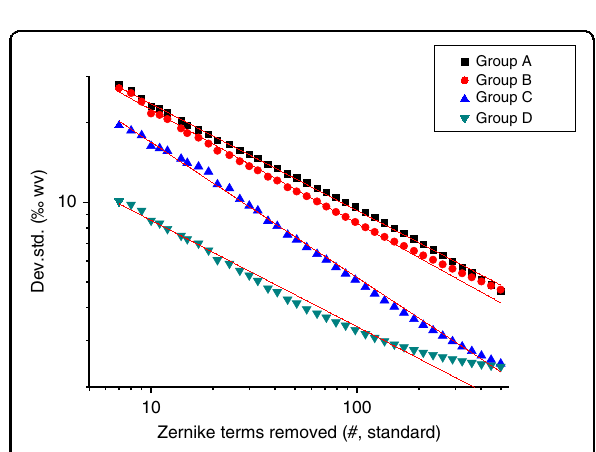
Fig. 20 Logarithmic fi tting curves of Zernike terms for the effect of air turbulence on interferometric tests. The slope of the curve represents the power relationship in double logarithmic coordinates